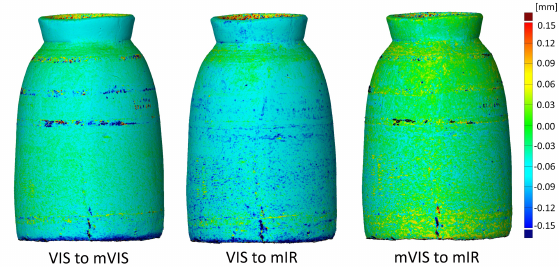
Figure 11. Surface discrepancy maps comparing the three resulting 3D reconstructions of the mango wood vase: VIS to mVIS, VIS to mIR, and mVIS to